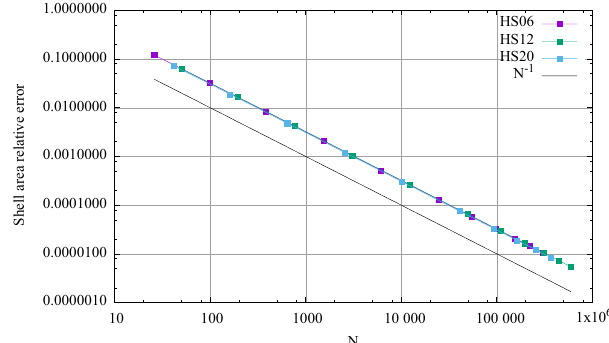
Figure 5. Relative shell area error as a function of its number of nodes ( N